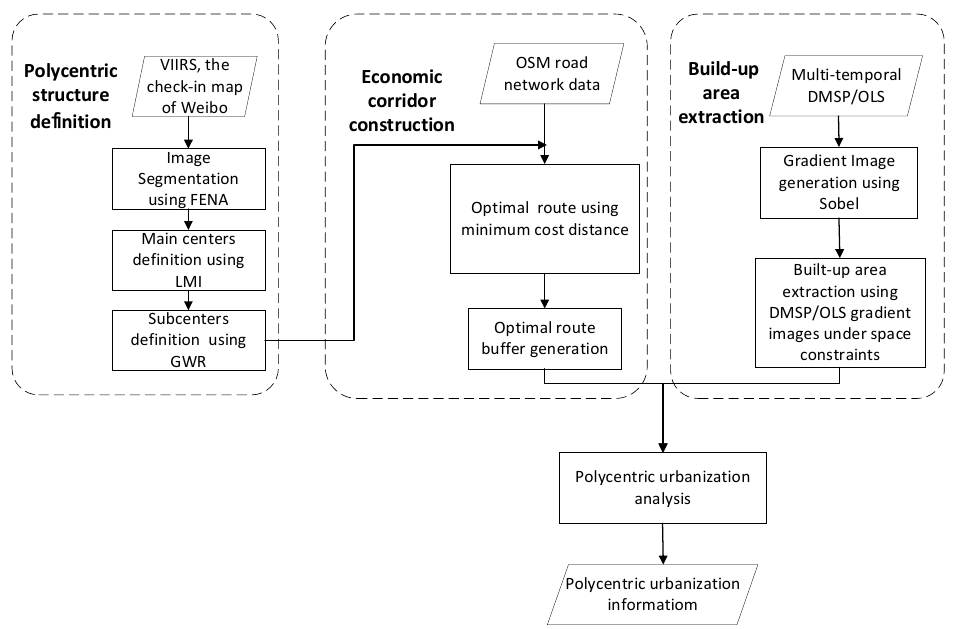
Figure 1. Flowchart of the proposed polycentric urbanization analytical model, which uses multisource big geospatial data.